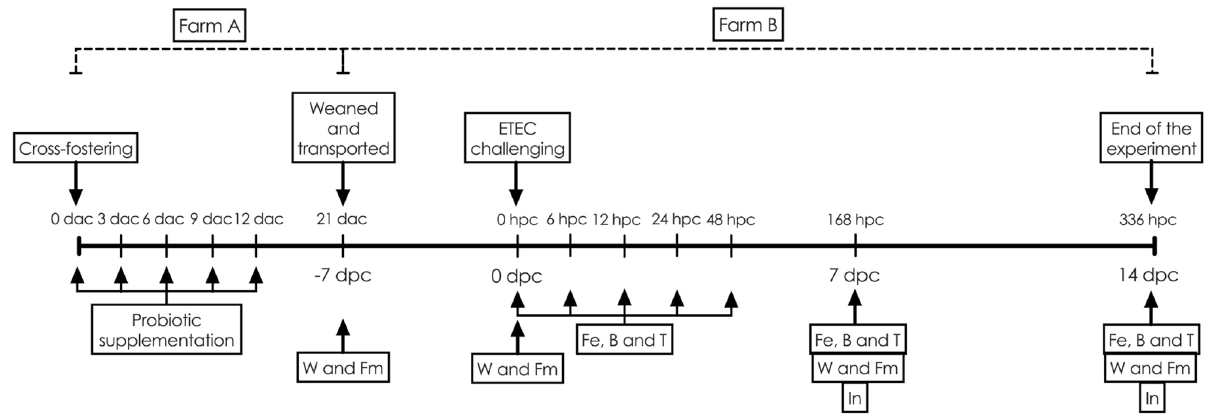
Figure 1. Schematic of experimental designs and sample collection. W = weighing (body weight and feed intake), Fm = Faecal collection for microbial profile analysis, Fe = Faecal collection for ETEC shedding and consistency scoring determination, B = Blood collection, T = Rectal temperature record, and In = Small intestinal collection. dac = day after cross-fostering, hpc = hour post-challenge and dpc = day